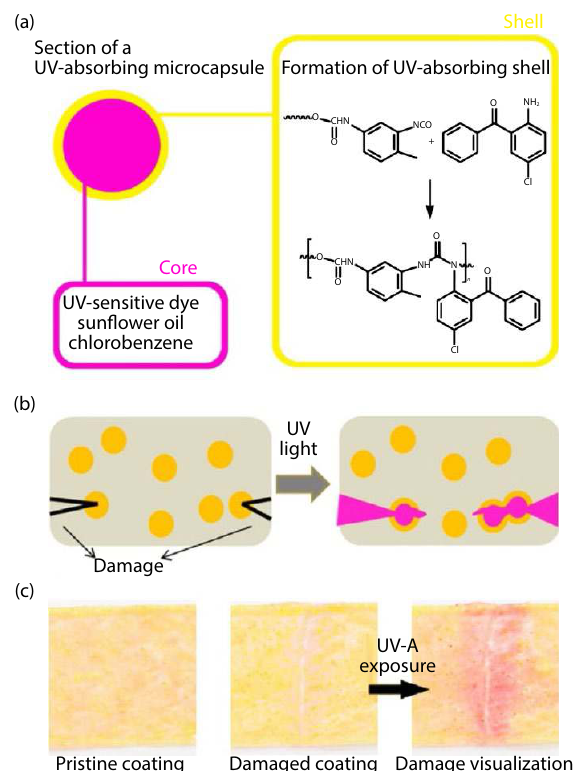
Fig. 14 A UV-induced self-reporting coating based on UV-absorbing mi- crocapsules with photochromic payloads. ( a ) Schematic cross-section of the synthesized micro-capsules with main constituents and shell formation scheme. ( b ) Schematic representation of the visual identification of the mechanical dam- age by exposure to UV-A light. ( c ) Damage visualization process of microcap- sule-containing self-reporting films. Reproduced with permission from ref.